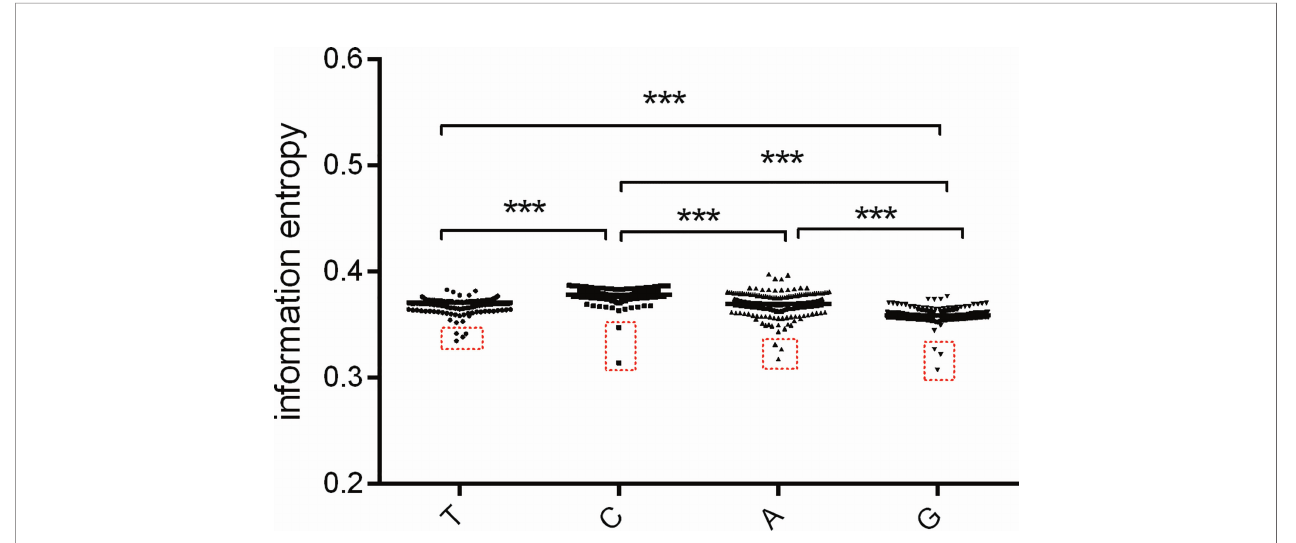
FIGURE 4 | The usage bias for the speci fi c nucleotide (A, T, G, or C) in the atg13 genes of 226 eukaryotic organisms represented by information entropy. The red box with broken lines highlights the outliers which correspond to atg13 genes of the speci fi c organisms. *** means p -value <